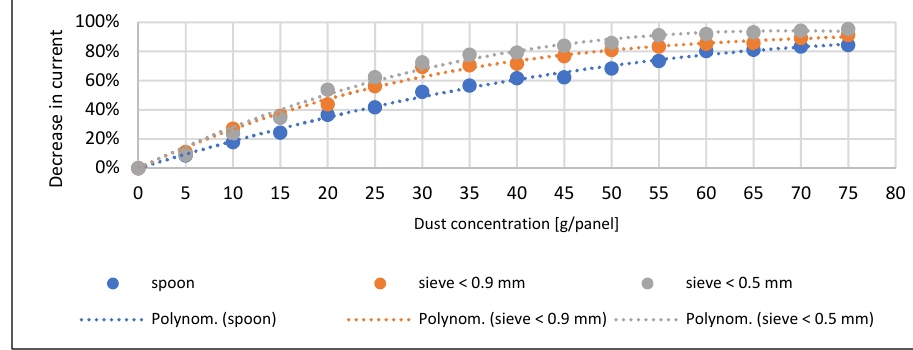
Figure 11. The short ‐ circuit current values as a function of the fly ash concentration.